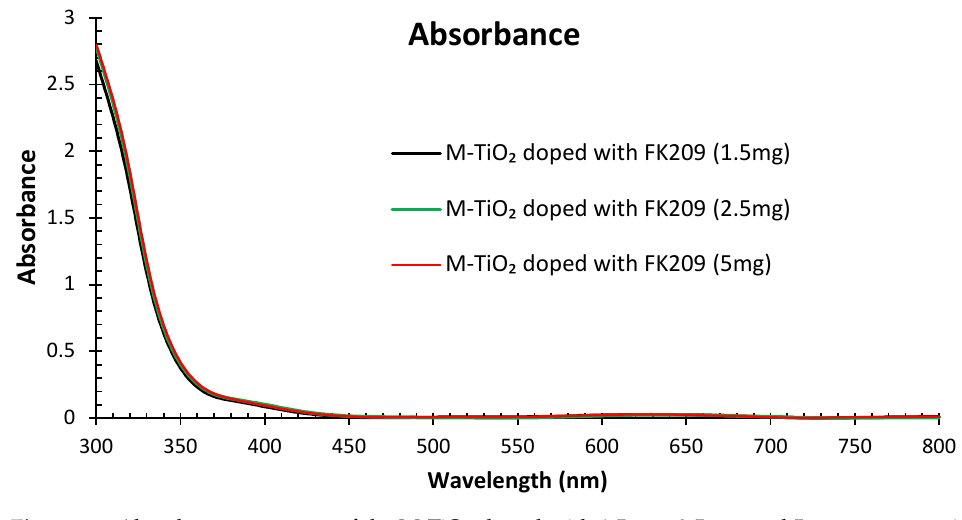
Figure 14. Absorbance spectrum of the M-TiO 2 doped with 1.5-mg, 2.5-mg and 5-mg concentrations of FK209 cobalt .